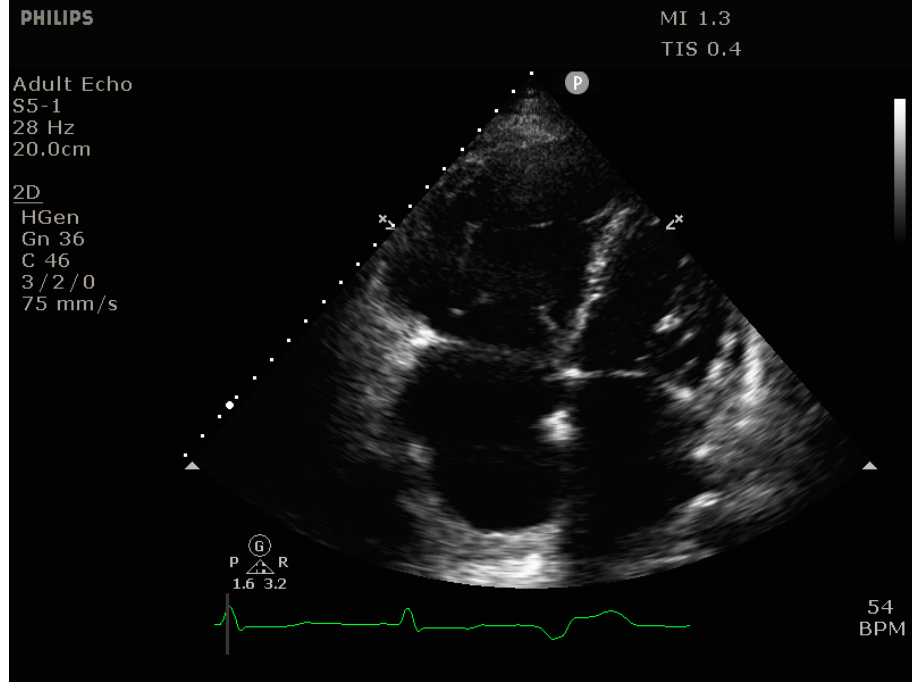
Figure 4. Transthoracic echocardiogram (apical 4-chamber view) showing massive right ventricular dilation (RV diameter > LV diameter).